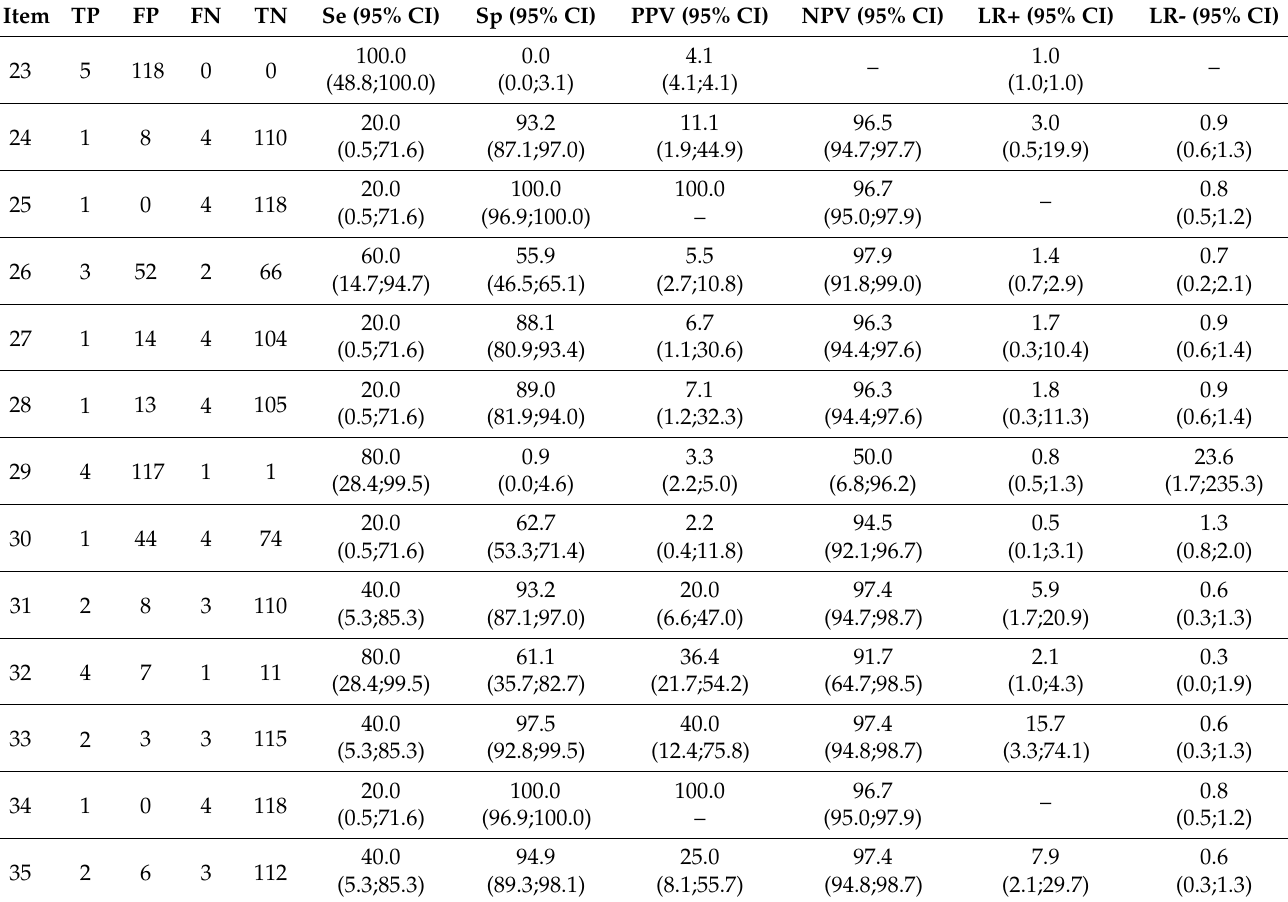
Table 2. Accuracy of the additional 15 items for OSAS: sensitivity, specificity, predictive values and likelihood ratios, with 95%